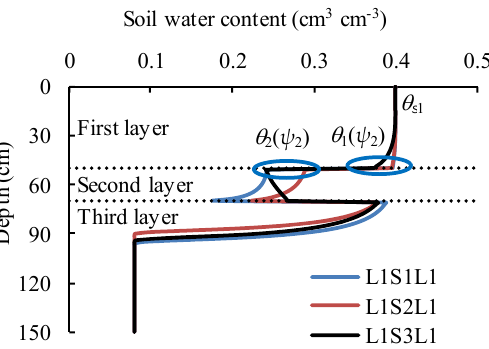
of sand is 50 cm and the infiltration time is 300 min.